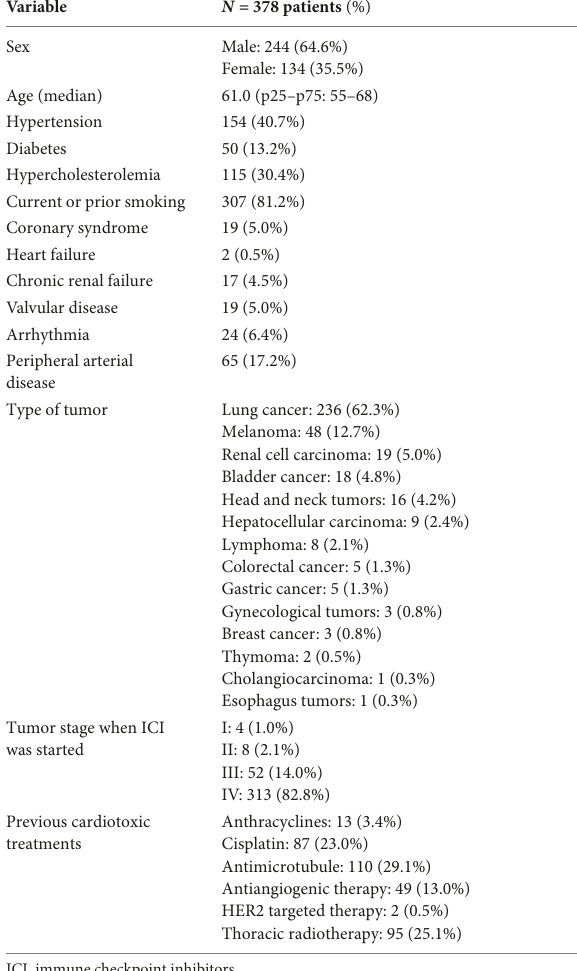
TABLE 2 Type of ICI treatment received.